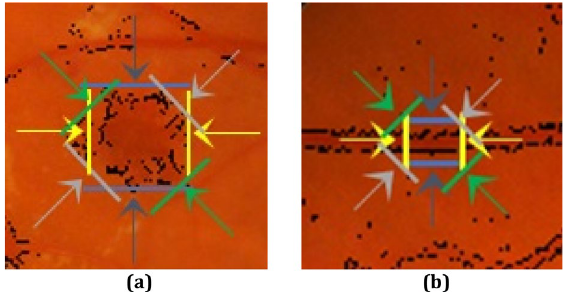
Figure 2. Directional intensity changes in ( a ) red-lesion, ( b ) blood